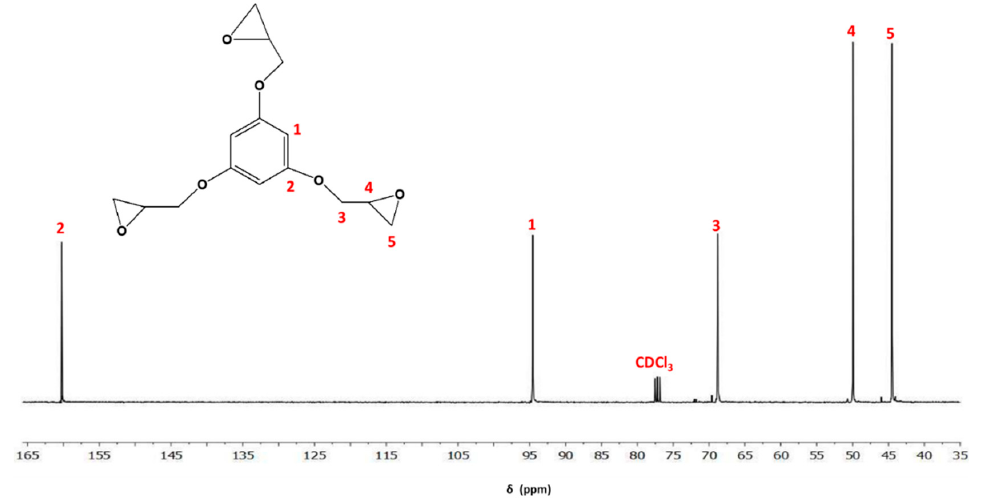
Figure 3. 13 C-NMR spectrum of 3EPO-Ph monomer in CDCl 3 .